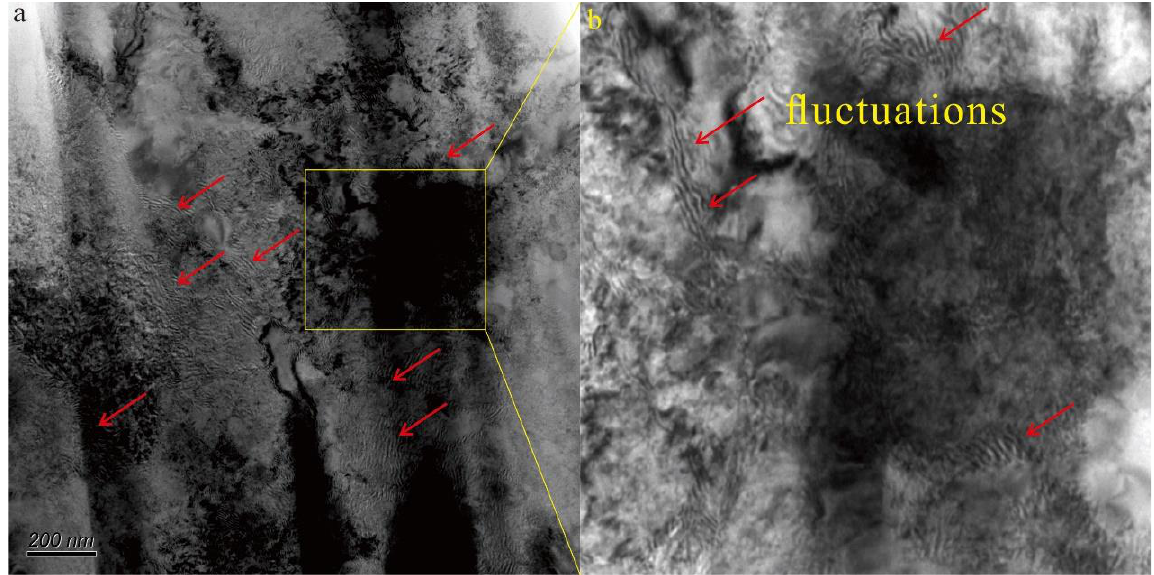
Figure 3. ( a ) HR-TEM imaging of the bornite – chalcopyrite intergrowths, showing that many small alternately dark and bright fluctuations occur in the chalcopyrite and bornite solid solutions (red arrow). ( b ) High-magnification transmission electron microscopy image obtained from the yellow square in Figure 3a.